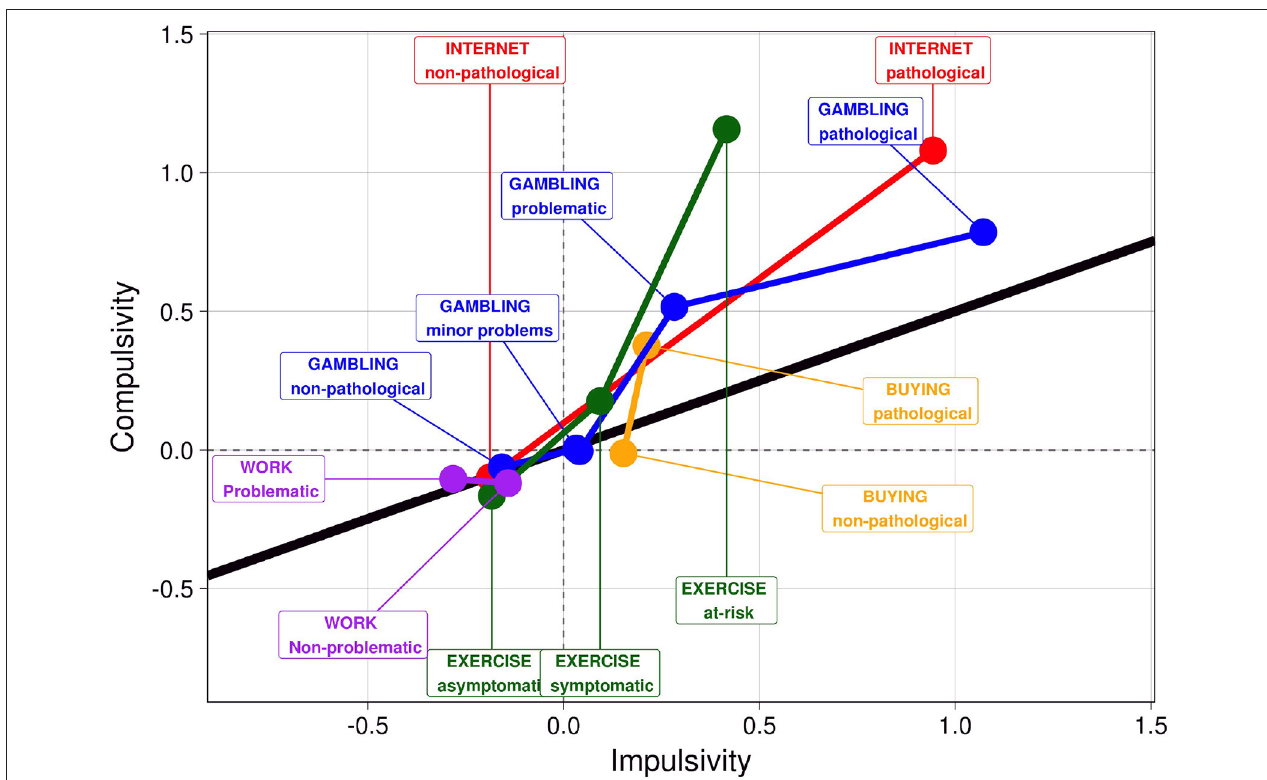
FIGURE 1 | Impulsivity and compulsivity within problem groups in the representative sample. Impulsivity and compulsivity scores were standardized within the sample, and the standardized values are present in the Figure. The solid black line indicates the (theoretical) position when compulsivity and impulsivity are equally present in the given group. Values above the solid line indicate the dominance of compulsivity, whereas group means below the line indicate the dominance of